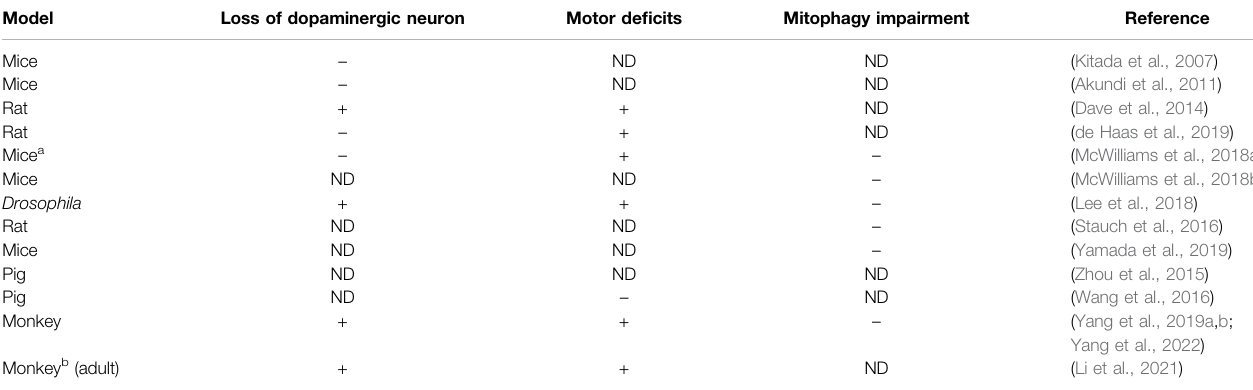
TABLE 1 | PINK1 knock out animal